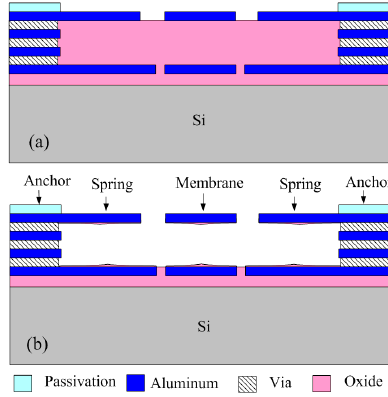
Figure 8. Fabrication flow of the switch: ( a ) after the complementary metal oxide semiconductor (CMOS) process; and ( b ) after the post-process.